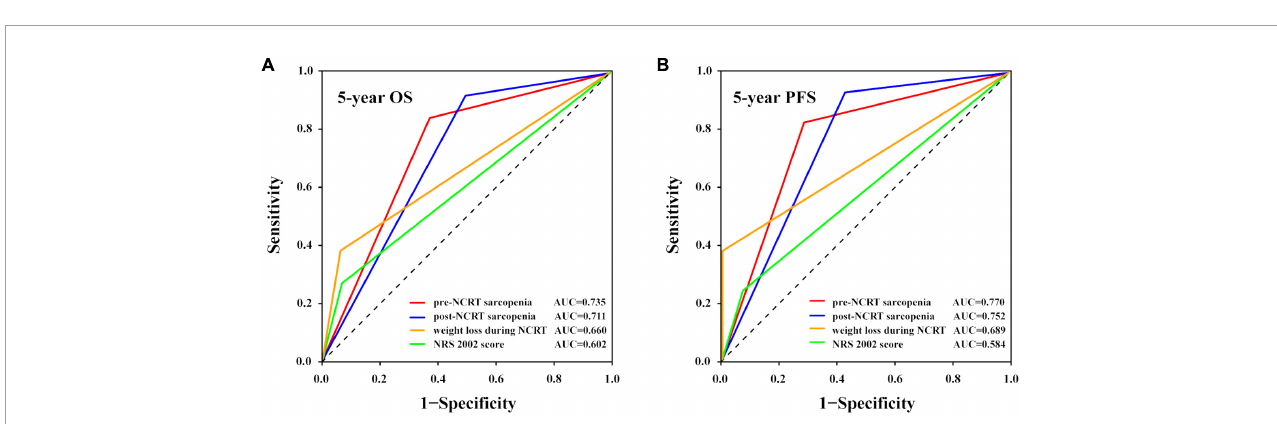
FIGURE3 Prognostic accuracy of different nutritional indices compared using ROC curves with AUC values. The (A) 5-year OS and (B) 5-year PFS rates. AUC, area under the curve; NCRT, neoadjuvant chemoradiotherapy; NRS 2002, nutritional risk screening 2002; OS, overall survival; PFS, progression-free survival; ROC, receiver operating